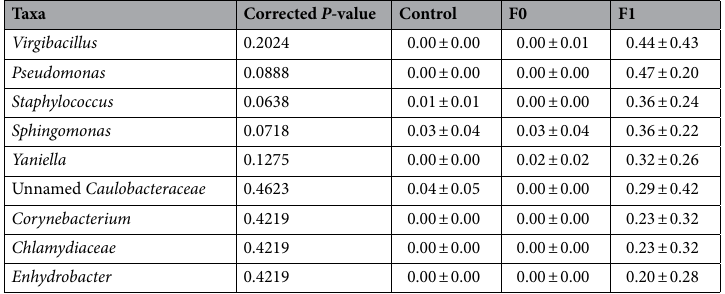
Table 3. Mean relative abundance (%) ± SD of the predominant phyla, classes, orders, families, and genera found in C. hemipterus among the three study groups. Different letters in the same row indicate statistical significance between taxonomic abundance based on STAMP analysis using ANOVA followed by Tukey– Kramer and Benjamini–Hochberg correction ( P <